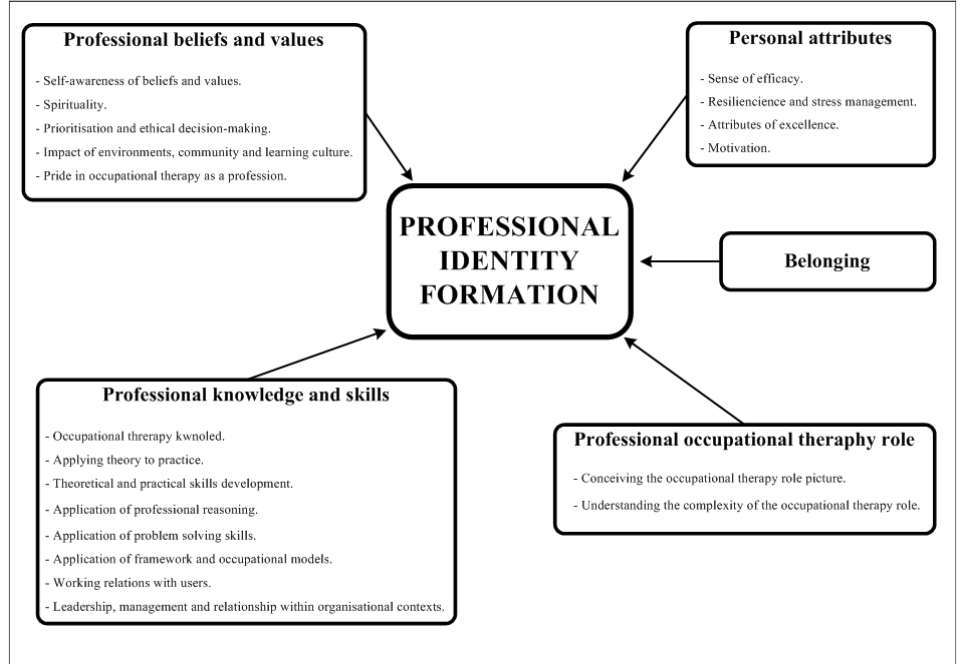
Figure 2. Components of professional identity formation and associated learning outcomes.